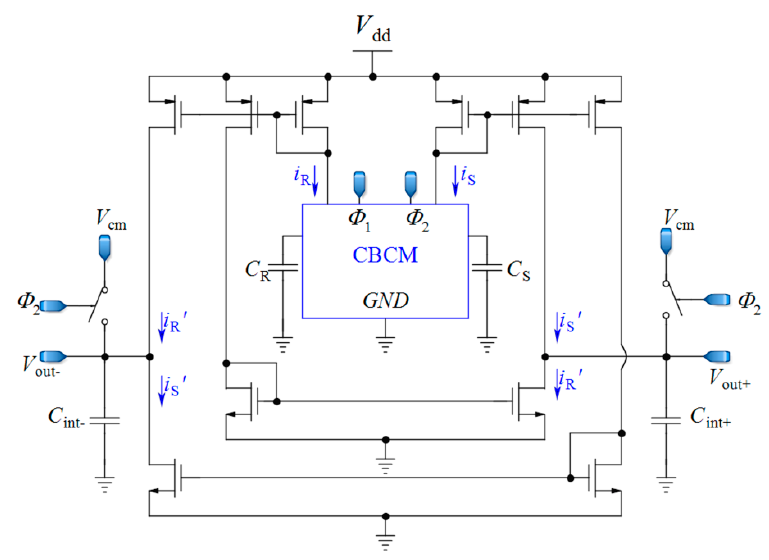
Figure 5. Fully differential core-CBCM CVC adapted from [60,64].